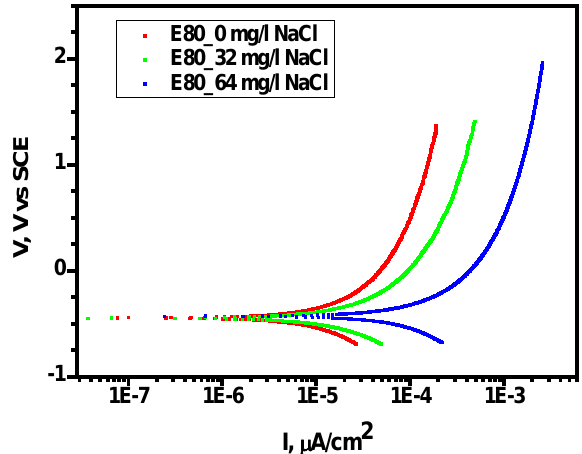
Figure 6. Post-corrosion scanning electron microscope (SEM) images of MAS at 1000× after 60 days immersion in ( a ) E80 + 0 mg/L NaCl with cracks present; and ( b ) E80 + 32 mg/L NaCl showing micro-pits.